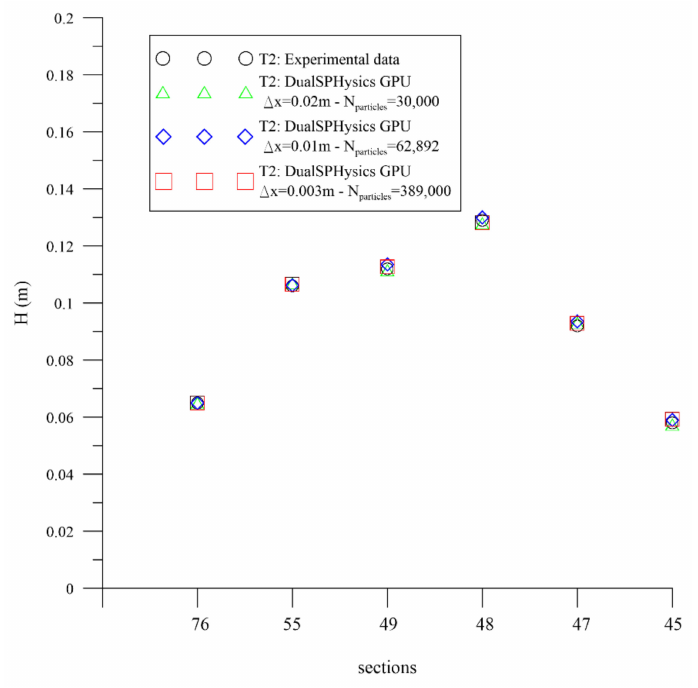
Figure 3. Effect of the initial particle resolution Σ on the SPH numerical simulation of test